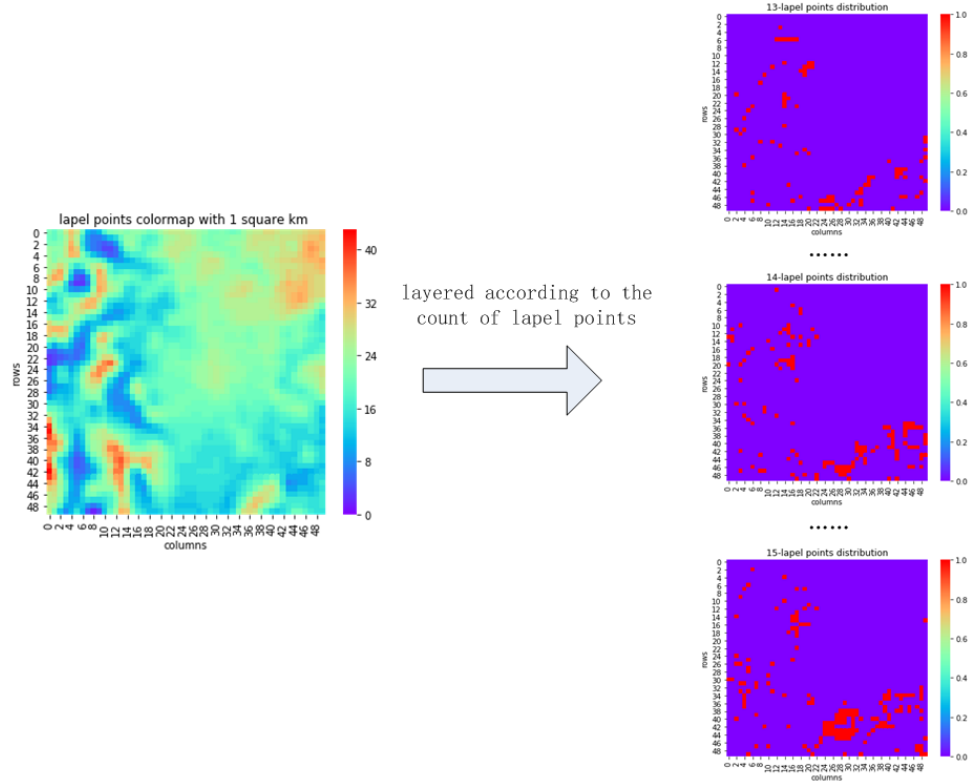
Figure 16. The layering heatmap according to the number of each lapel